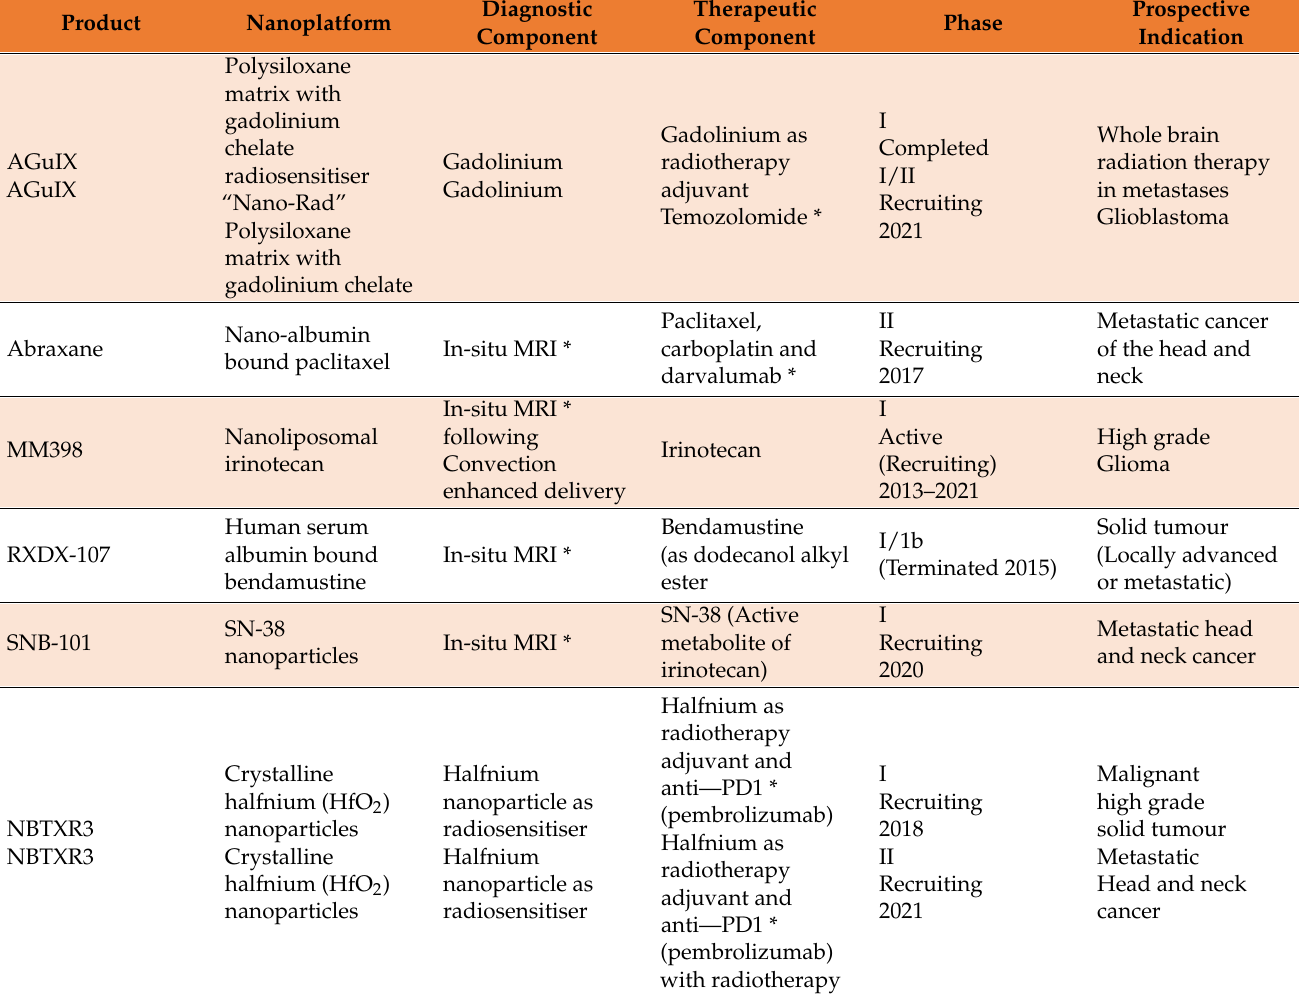
Table 3. Overview of current nanotheranostics in clinical development as of Q4